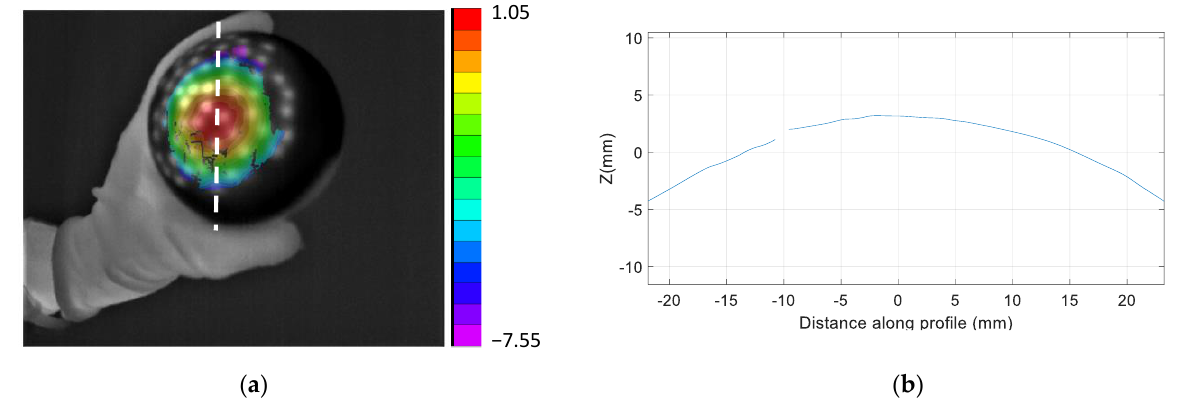
Figure 6. Results for digitalization a rubber ball. ( a ) Image of digitalization. ( b ) Shape profile along whit dashed line in ( a ) .